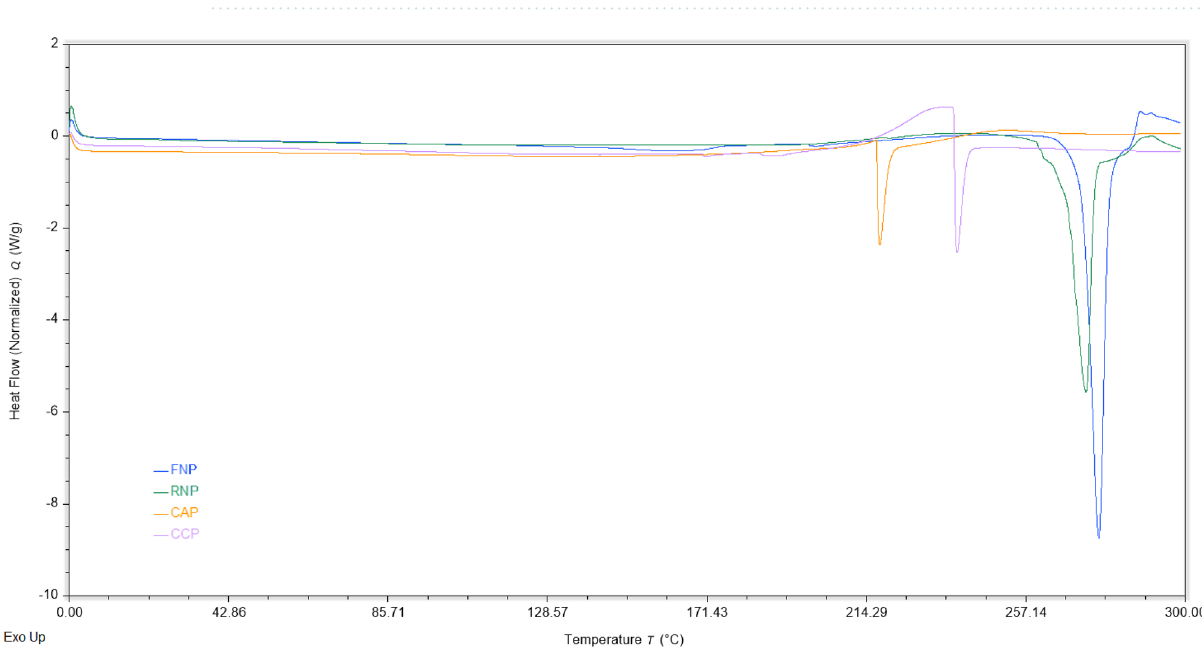
Figure 4. DSC thermograms of pectin extracted from grape pomace (FN and RN) by MAE under the optimal conditions, commercial apple and citrus pectin (CAP and